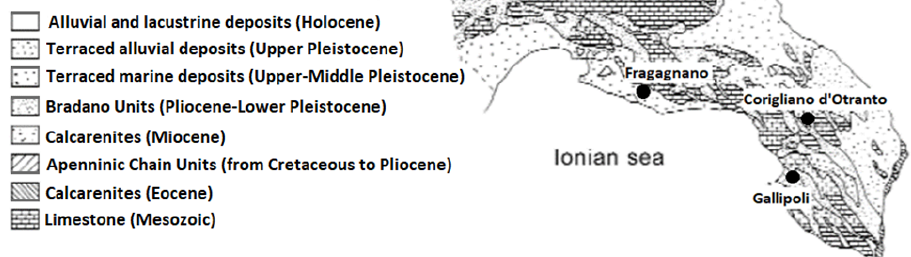
Figure 1. Geological map of Salento area with geographic localization of quarries.